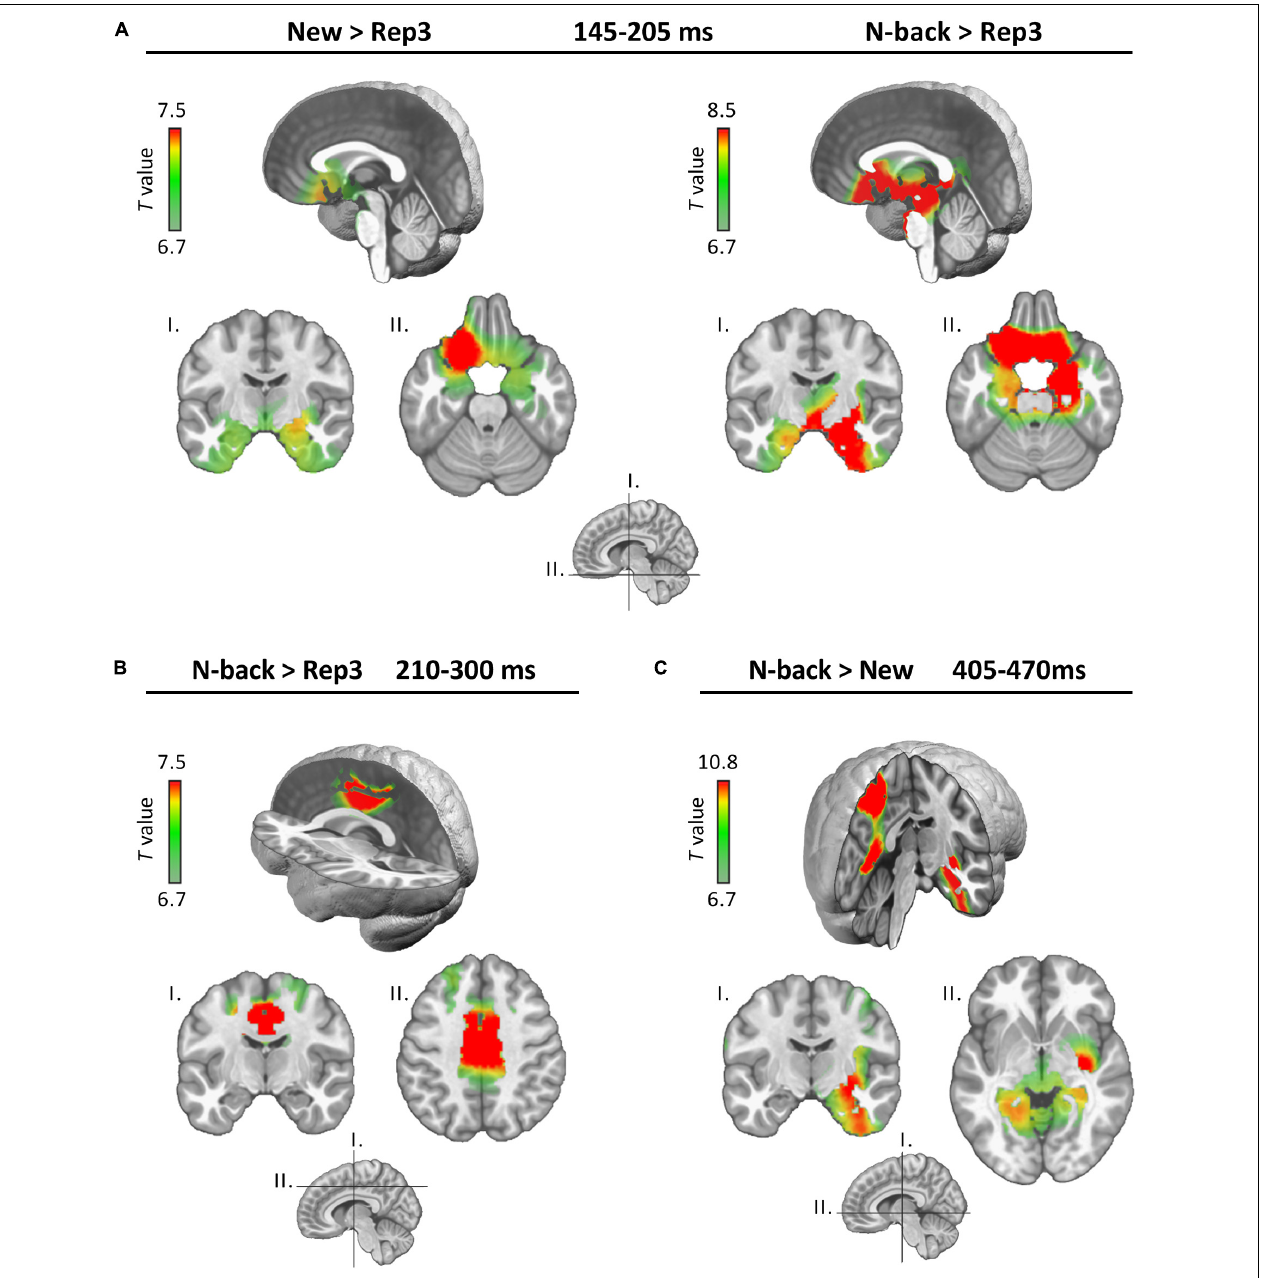
FIGURE 3 | Source estimations. Estimated neural generators emerging from the indicated comparisons in the three periods ( A: 145–205 ms, B: 210–300 ms, and C: 405–470 ms). Only significant differences are displayed.